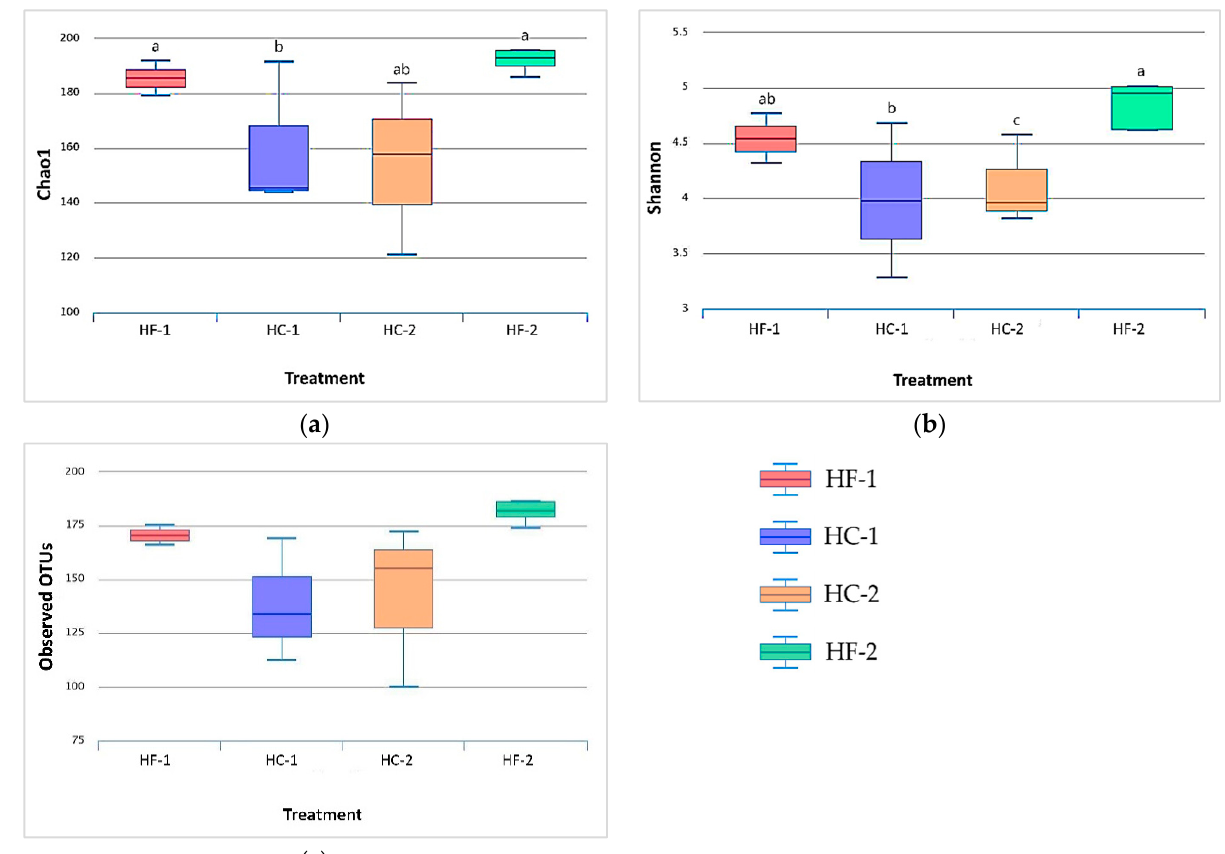
Figure 4. Boxplot representation of alpha diversity indices: ( a ) chao1, ( b ) Shannon, and ( c ) observed OTUs, between diet groups. Alpha-diversity metrics’ visualization were done in MetaCOMET [40] and computed using QIIME [39]. HF-1, high-forage diet; HC-1, high-concentrate diet; HC-2, high-concentrate diet; HF-2, high-forage diet. a–c superscript denotes significant differences ( p < 0.05).